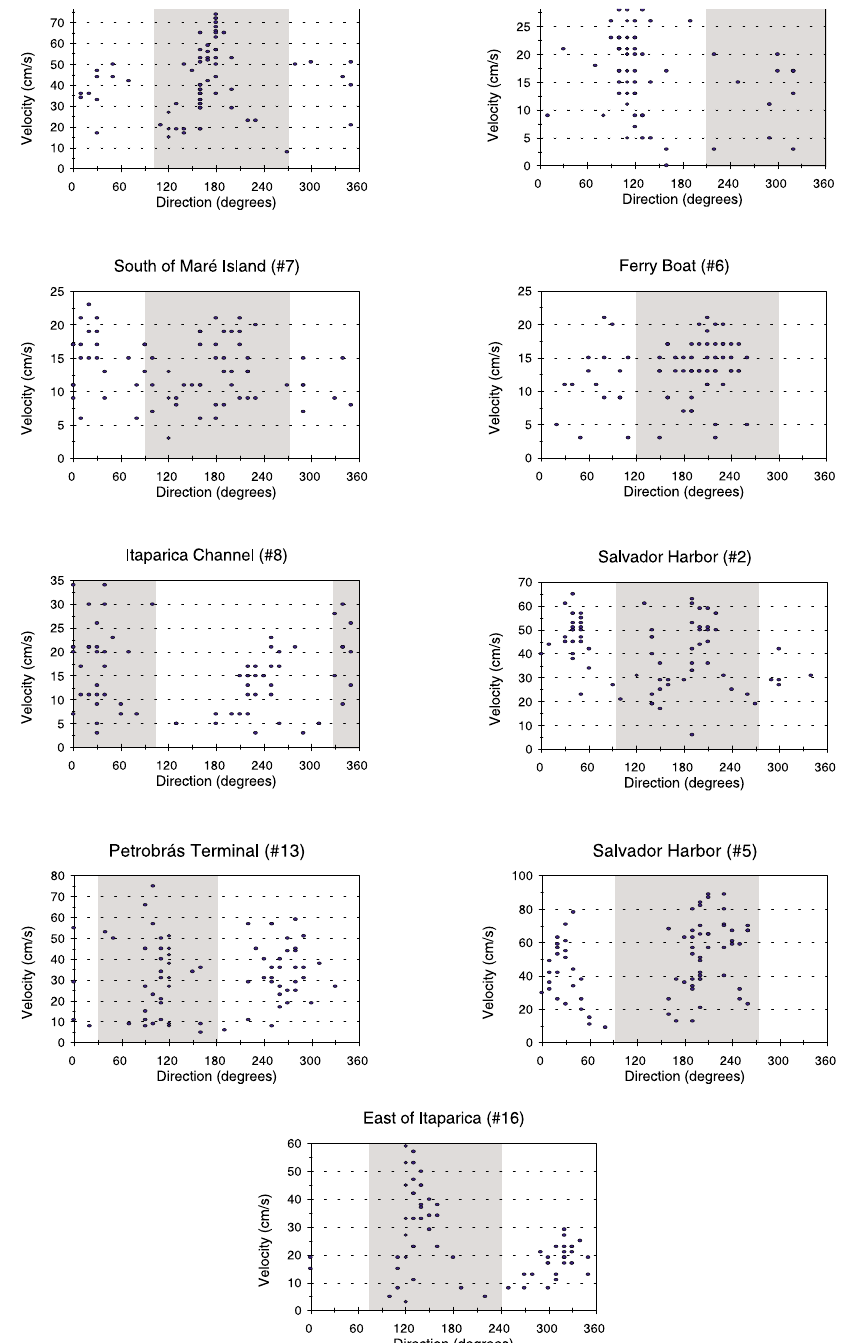
Fig. 8 – Tidal current velocities at 5 m of depth at some stations and their respective directions. Shaded zones indicate ebb-directed flows whereas clean zones indicate flood-directed